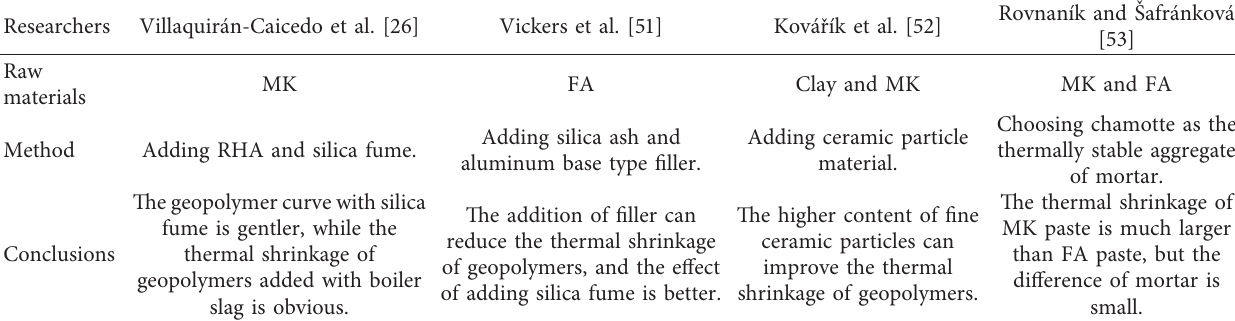
Table 1: Effects of different measures on thermal